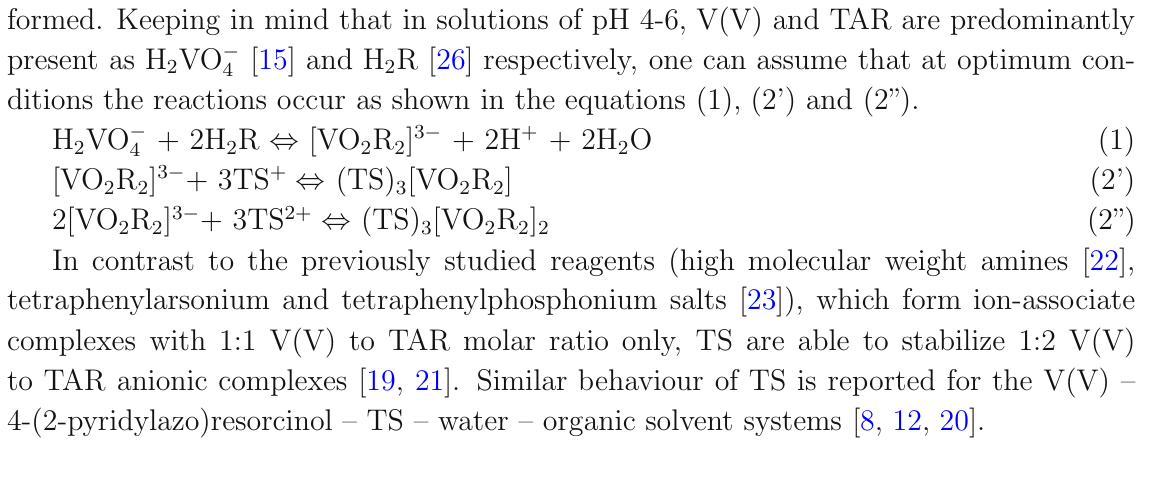
=2x10 − 5 mol l − 1 , V ( V ) =2x10 − 4 mol l − 1 , INT =2x10 − V ( V )